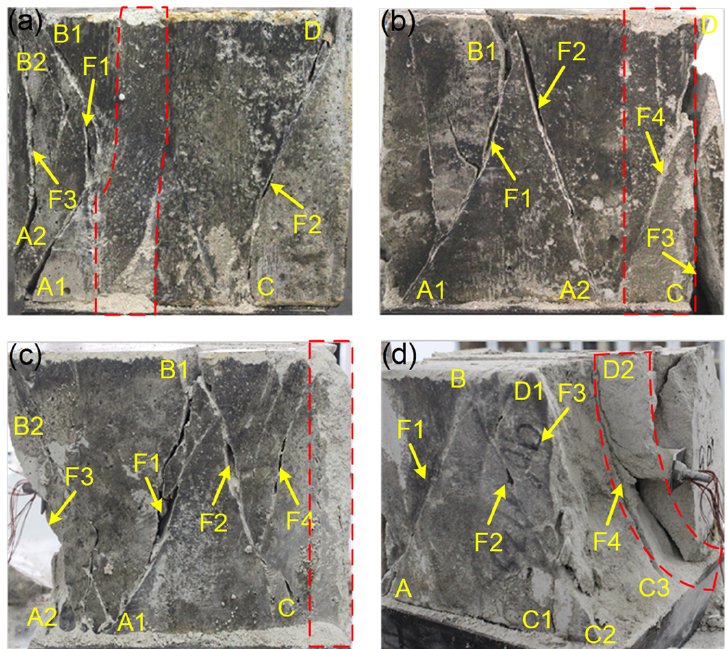
Figure 13. Failure mode of samples containing weak interlayer with different dip angles: ( a ) α = 15°; ( b ) α = 30°; ( c ) α = 45°; ( d ) α = 90°.